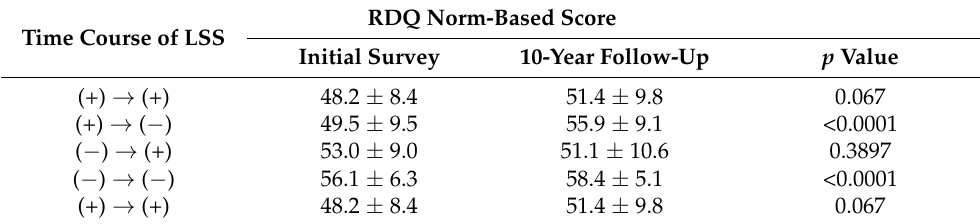
Table 3. Time course of LSS and RDQ norm-based